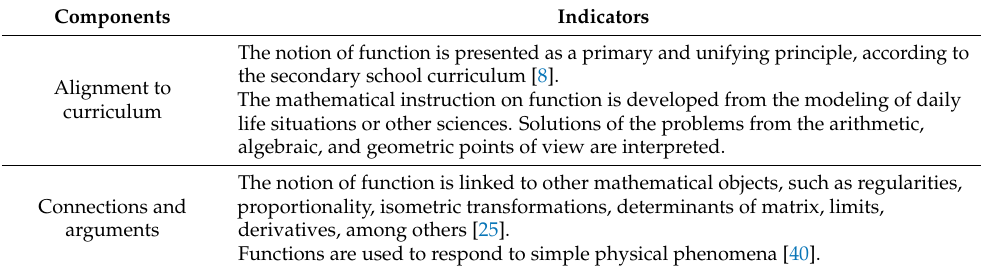
Table 6. Ecologic suitability for the teaching of